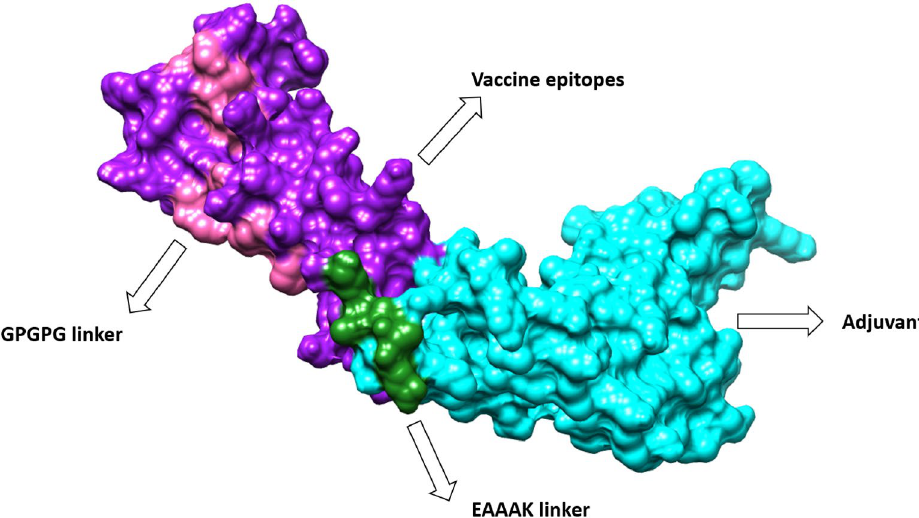
Figure 6. A candidate vaccine construct comprises GPGPG linkers in pink color, subunits of cholera toxin B in cyan blue color, and forest green representing EAAAK linkers, as well as vaccine epitopes are represented by purple.